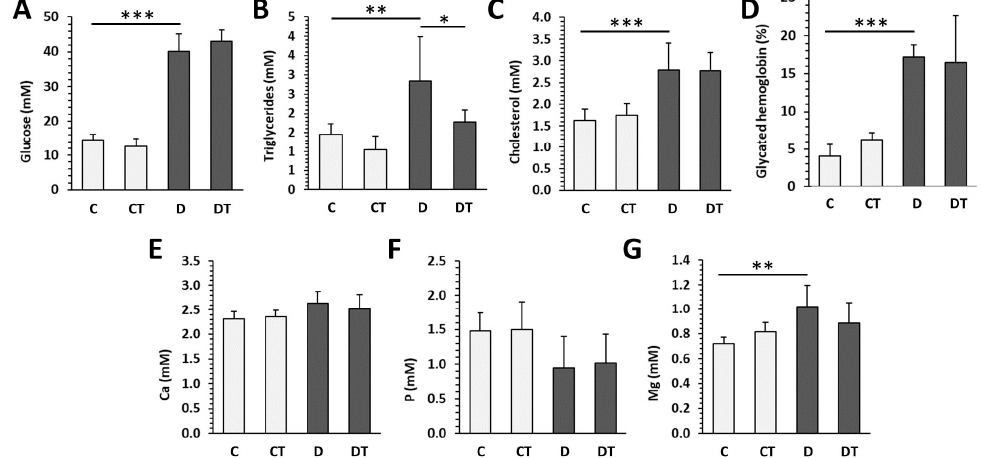
Figure 1. Biochemical parameters examined in non-diabetic rats (C), those treated with cemtirestat (CT), STZ-induced diabetic rats (D), and those treated with cemtirestat (DT). ( A ) Blood glucose, ( B ) triglycerides, ( C ) cholesterol, ( D ) glycated hemoglobin, ( E ) calcium, ( F ) phosphorus, and ( G ) mag- nesium. The values are represented as mean ± SD. Only differences between groups C and D, as well as C and CT, and D and DT are indicated (* p < 0.05, ** p < 0.01, *** p < 0.001).